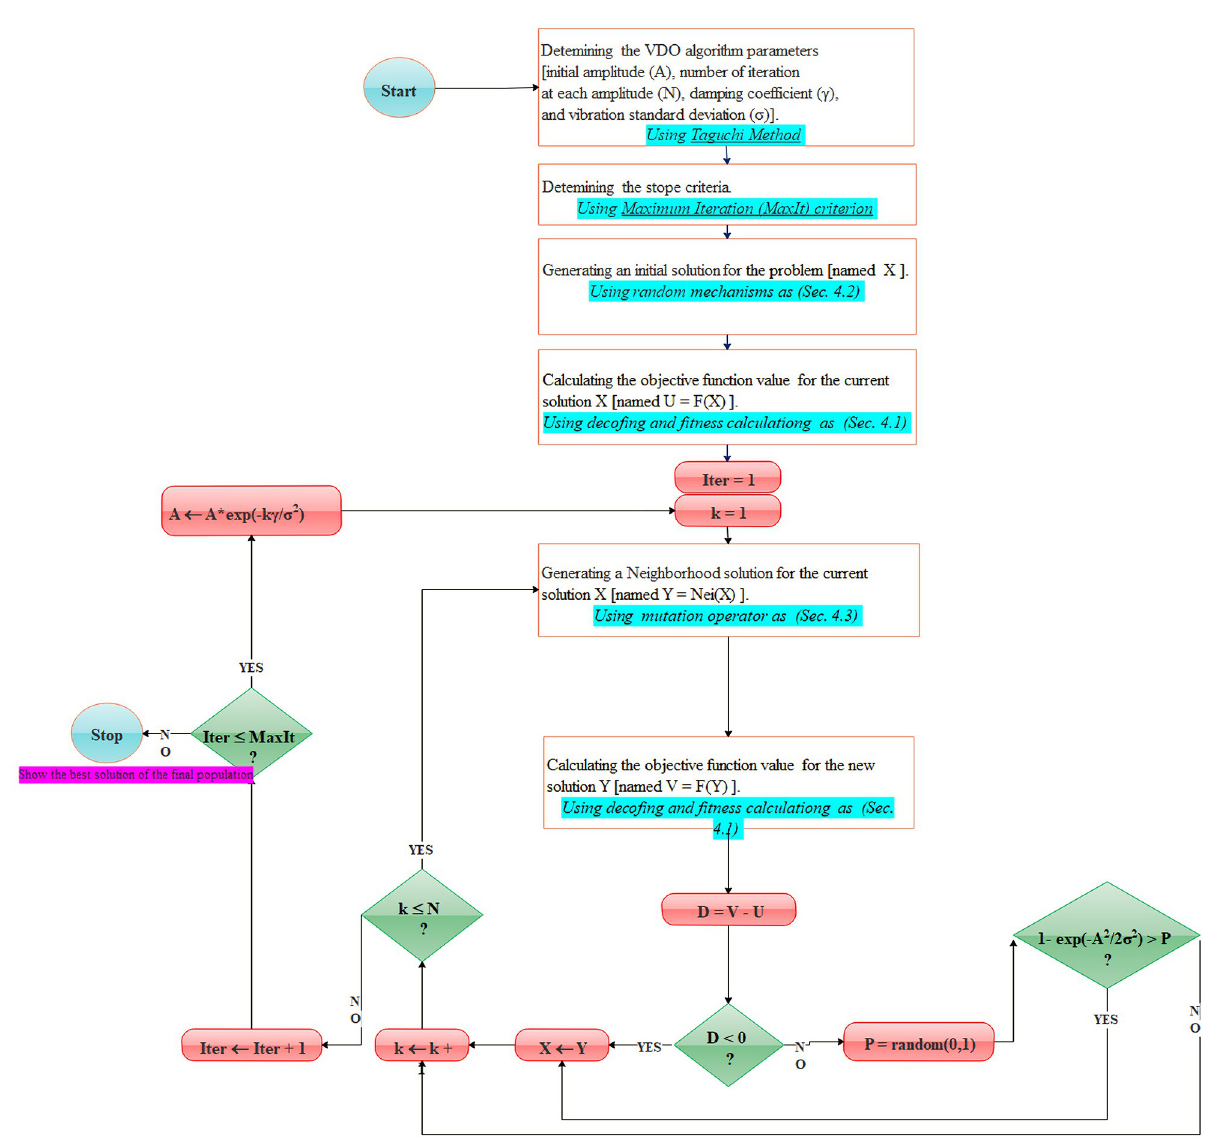
Fig 3. The flowchart of the proposed VDO solver in solving the